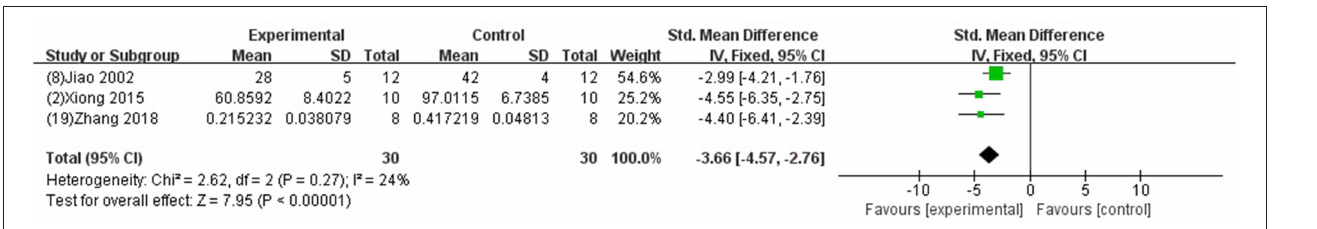
FIGURE 3 | Methodological quality for each study included.